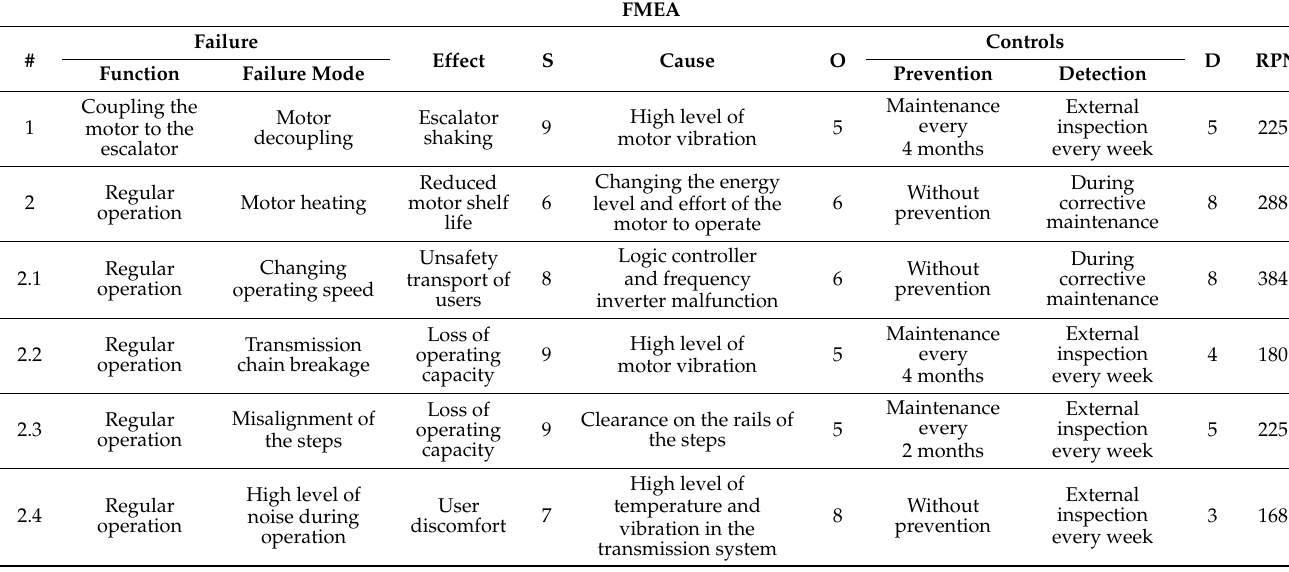
Table 11. FMEA before selected smart sensor installation.